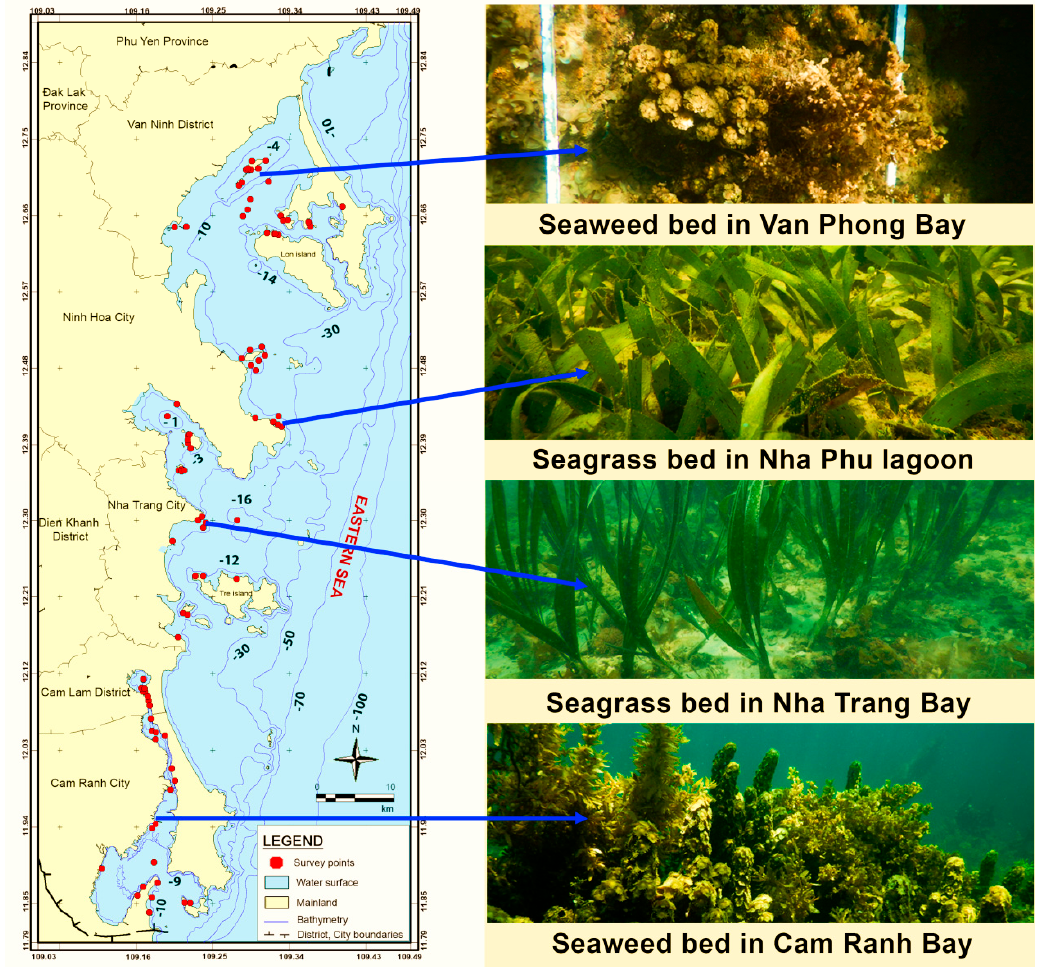
Figure 2. Survey sites along the Khanh Hoa coast, with pictures of various substrates (the blue lines in the ocean are isobaths).